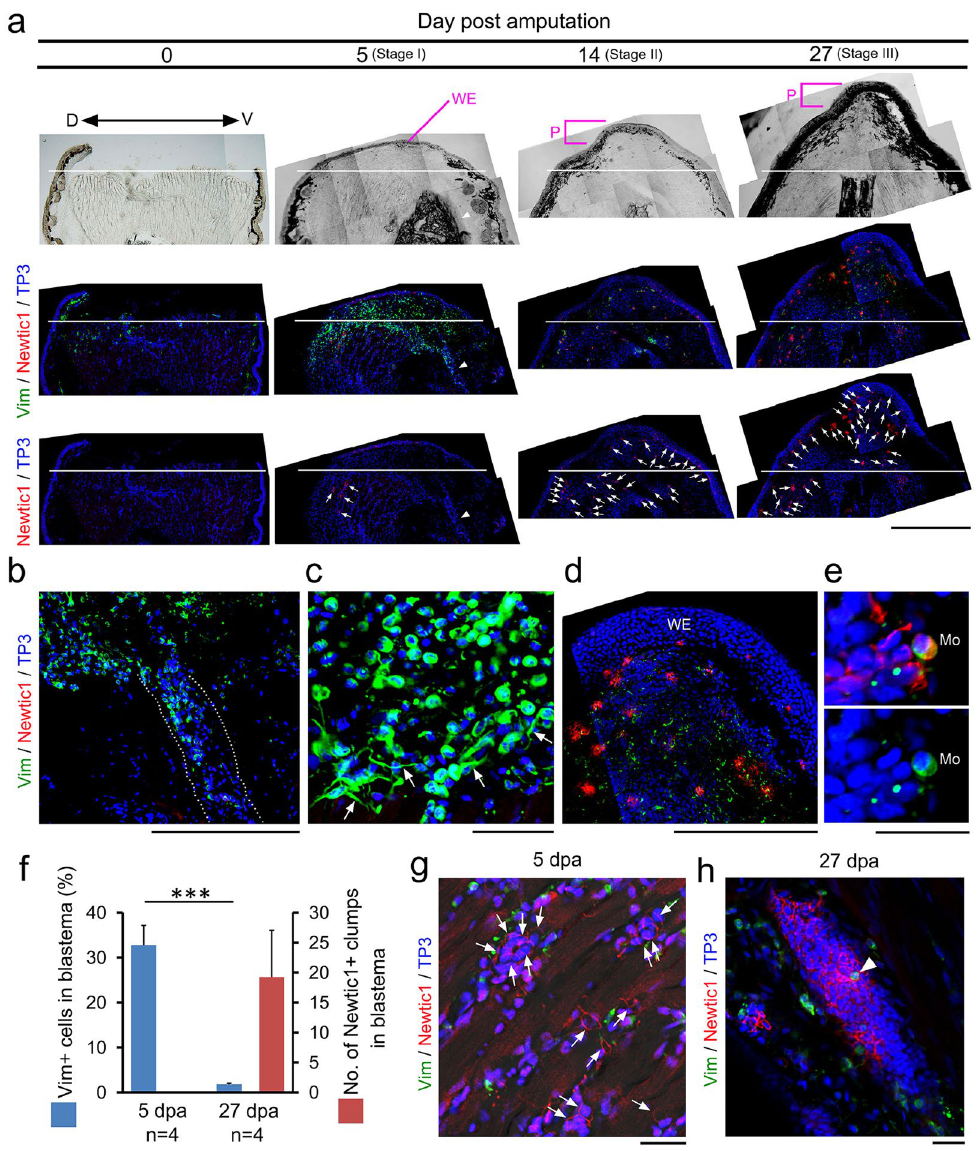
Figure 4. EryCs are newly generated in the limb stump and accumulated in a distal portion of the blastema. ( a ) Change in distribution pattern of EryCs and vimentin-immunoreactive (Vim + ) cells during blastema formation (n = 4 each). Arrows indicate EryCs. Arrowheads in 5 dpa indicate a large blood vessel containing Vim + cells. White line: amputation plane. WE: wound epidermis. P: protrusion. Topro-3 (TP3): nucleus. D: dorsal side. V: ventral side. Scale bar, 1 mm. ( b ) Enlargement of the blood vessel (arrowhead in a ). Dotted lines indicate the wall of the vessel. Vim + cells in the vessel, which were exclusively monocytes, seemed to be released from the open- end of the vessel into the blastema. Scale bar, 500 μ m. ( c ) Enlargement of Vim + cells in the blastema at 5 dpa in ( a ). Almost all of the Vim + cells were morphologically identified as monocytes. Some cells with long processes (arrows) that gathered around the amputation plane also showed vimentin immunoreactivity. Scale bar, 100 μ m. ( d ) Enlargement of the protrusion of blastema at 27 dpa in ( a ). Scale bar, 500 μ m. ( e ) Representative image showing monocytes (Mo) in the blastema at 27 dpa (n = 3). Scale bar, 50 μ m. ( f ) The proportion of Vim + cells and the number of Newtic1 + clamps in a blastema at 5 and 27 dpa. At 5 dpa, Vim + cells (178–283/section) occupied ~32.8% of cells in the blastema, while Newtic1 immunoreactivity did not appear in the blastema. In contrast, at 27 dpa, a large number of Newtic1 + clamps were distributed in the blastema (11–32/section), while the proportion of Vim + cells in the blastema (7–17/section) declined to ~1.8% (Welch’s t -test, *** p < 0.001; see Methods). ( g ) Appearance of Newtic1 immunoreactivity in PcNobs accumulated in dilated capillaries in the region proximal to the amputation plane at 5 dpa. We enhanced the red signal in the image at 5 dpa in ( a ) to reveal weak fluorescence of Newtic1 immunoreactivity. Arrows point to Newtic1-immunoreactive PcNobs in dilated capillaries in between muscle fibers. Scale bar, 50 μ m. ( h ) Accumulation of Newtic1-immunoreactive PcNobs in thick blood vessels in the region proximal to the amputation plane in the regenerating forearm at 27 dpa (n = 3). Monocytes were occasionally observed in the blood stream (arrowhead). Scale bar, 100 μ